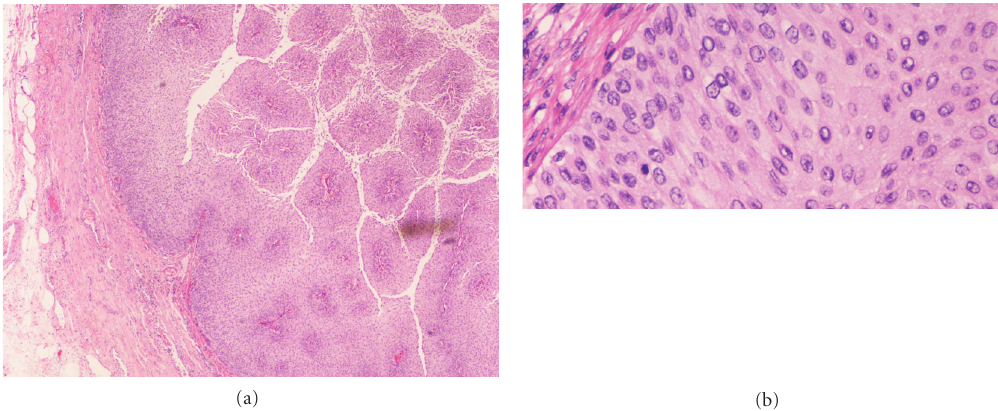
Figure 3: Section of the tumor at the superior renal pelvis, showing low-grade papillary transitional cell carcinoma, consisting of branching papillary fronds with fibrovascular cores ((a) low-power 4x objective). Note that tumor is confined to epithelium, with no invasion into the lamina propria or beyond. High-power view ((b) 40x objective) shows an orderly appearance of neoplastic cells with only mild nuclear pleomorphism and inconspicuous